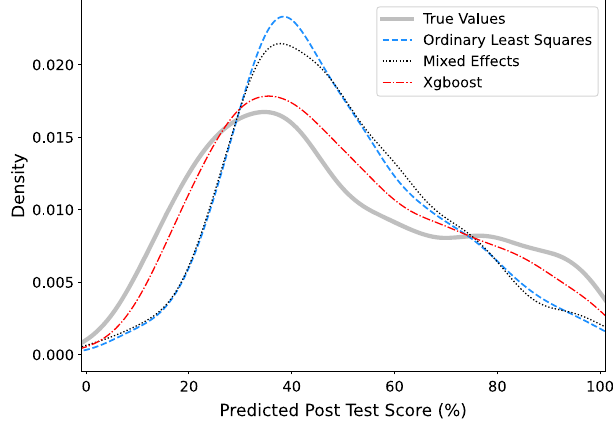
FIG. 3. A comparison of the out-of-sample predicted distribu- tions of post-test scores from the LASSO dataset. Curves represent the kernel density estimates of the predicted post-test scores. The gradient boosted model is closer to the true distribution than the ordinary least squares model and the mixed